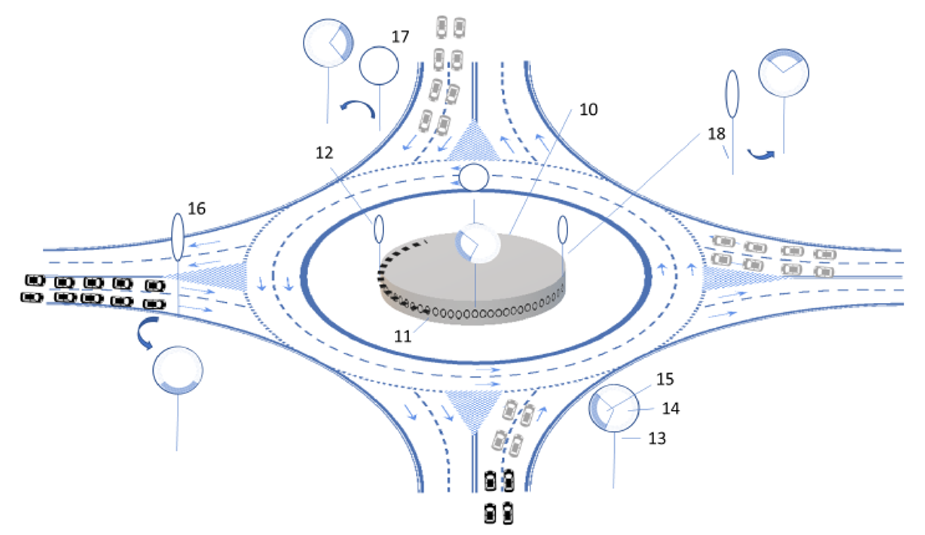
Figure 3. SYROPS roundabout signaling arrangement.